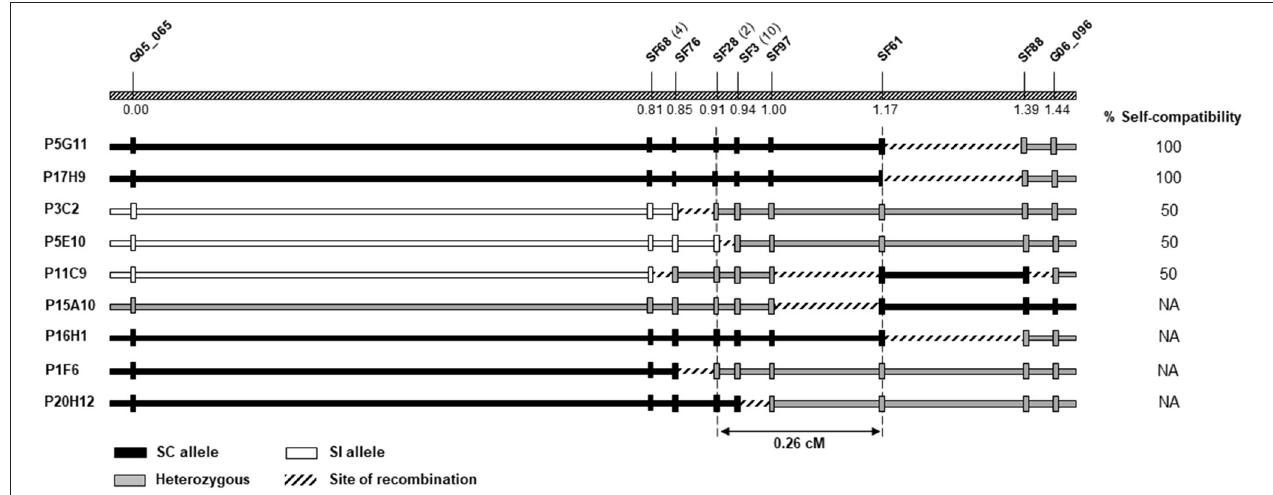
FIGURE 3 | Fine mapping of the self-compatibility (SC) locus on linkage group 5. The top bar shows the genetic order and distances in centimorgan (cM) of the nine informative markers used for the calculation of genetic distances. For SF68, SF28, and SF3, the number of co-segregating markers is indicated in brackets. Genotypes at each marker (vertical bars) and haplotype configuration (horizontal bars) for the nine individuals screened with G05_065 and G06_096 and the newly developed markers are shown. The column on the right side reports the phenotypes, when available. The dashed vertical lines at SF28 and SF61 limit the SC